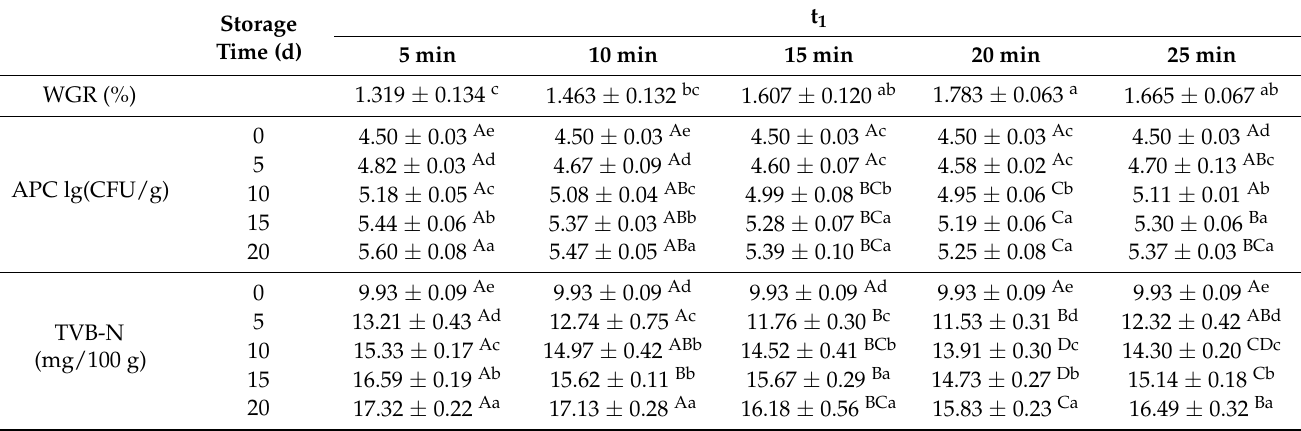
Table 5. Changes in WGR, APC, and TVB-N of tilapia fillets under different t 1 with fixed p v and t 2 .